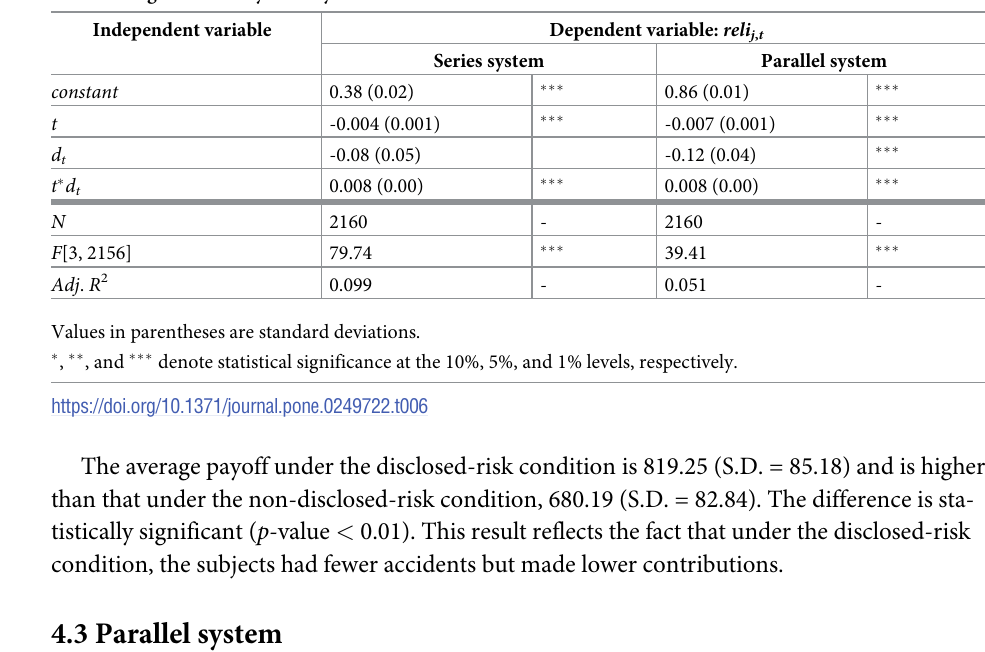
Table 6. Regression analysis on system reliabilities. Independent variable Dependent variable: reli j , t Series system Parallel system constant 0.38 (0.02) ��� 0.86 (0.01) ��� -0.004 (0.001)